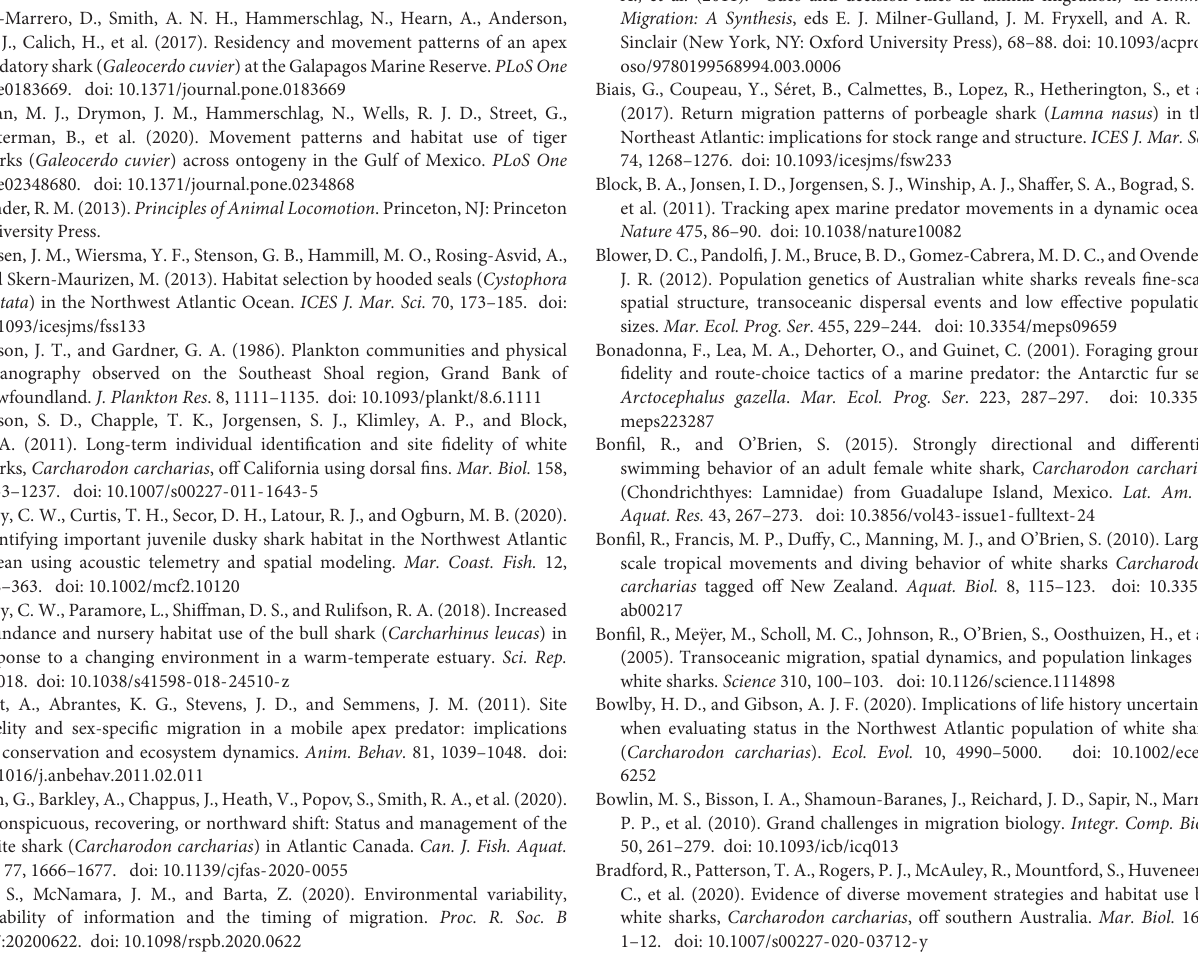
Supplementary Figure 1 | Proportions of locations across range of behavioral scores from the hSSM from locations over the continental shelf and off-the-shelf. Locations are color coded by behavioral score (1.00–1.25 = transient, 1.25–1.75, 1.75–2.00 = resident). Supplementary Figure 2 | Daily regularized locations for WS-13-01, a 4.4 m TL adult female white shark tracked for 1,473 days. Supplementary Figure 3 | Daily regularized locations for WS12-17, a 4.9 m TL adult female white shark tracked for 1,734 days. Supplementary Figure 4 | Daily regularized locations for WS-13-03, a 4.3 m TL adult female white shark tracked for 2,647 days. Supplementary Figure 5 | Time-at-temperature for four PSAT-tagged white sharks across behavioral seasons. (A) Late summer/early autumn; (B) southern migration; (C) overwintering; (D) northern migration.